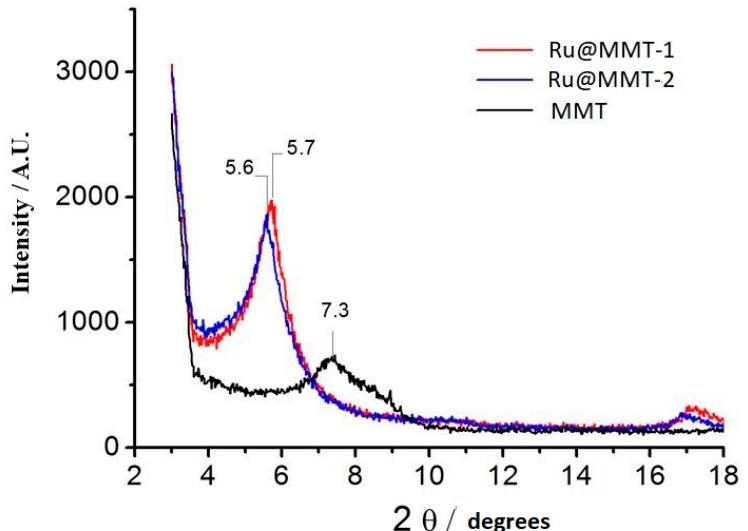
Figure 6. The X-ray di ff raction (X-ray) observed the characteristic peaks of Ru@MMT-1 and Ru@MMT-2 at 5.7 and 5.6 degree as a consequence of